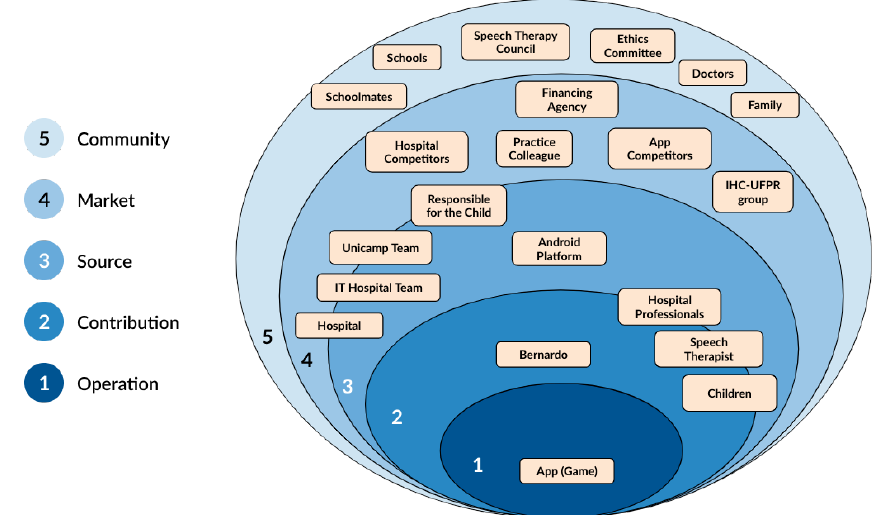
Figure 2. Stakeholders Diagram filled by the workshop